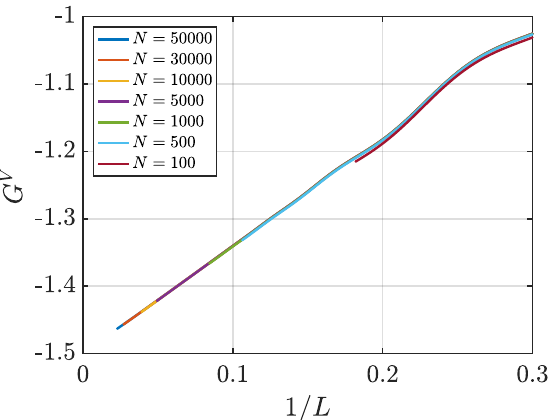
Figure 2. KB integrals of finite spherical subvolumes G V (Equation (4)) vs. 1/ L ( L is the diameter) for the WCA fluid at T = 2 and ρ = 0.6 (dimensionless units). The values of G V are computed for systems with varying number of molecules N . The used RDFs are provided in Figure 1.